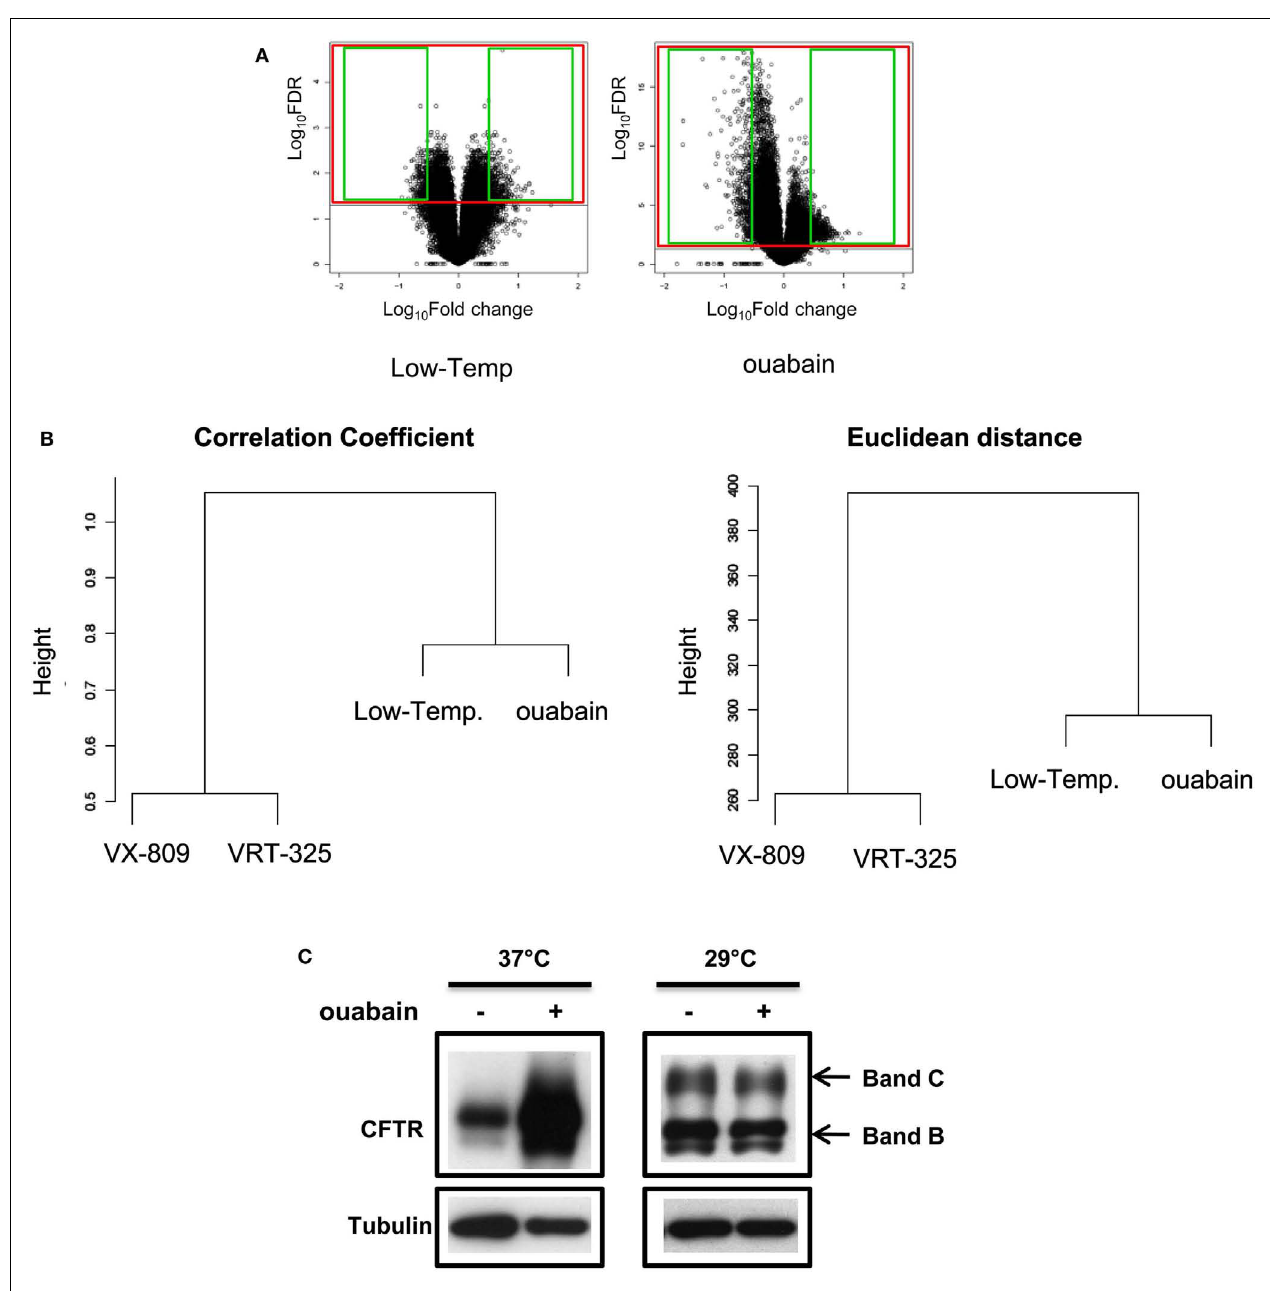
clustering of ouabain, low temperature,VRT-325 andVX-809 expression patterns (FDR ≤ 0.05) using standard Correlation coefficient and Euclidian distance as similarity measures.The distance between clusters was computed according to complete linkage. (C) CFBE/F508del-CFTR cells were treated with or without 0.1 µ M ouabain for 48h at 29 or 37˚C, the cell lysates were analyzed by immunoblotting with anti-CFTR or anti-tubulin